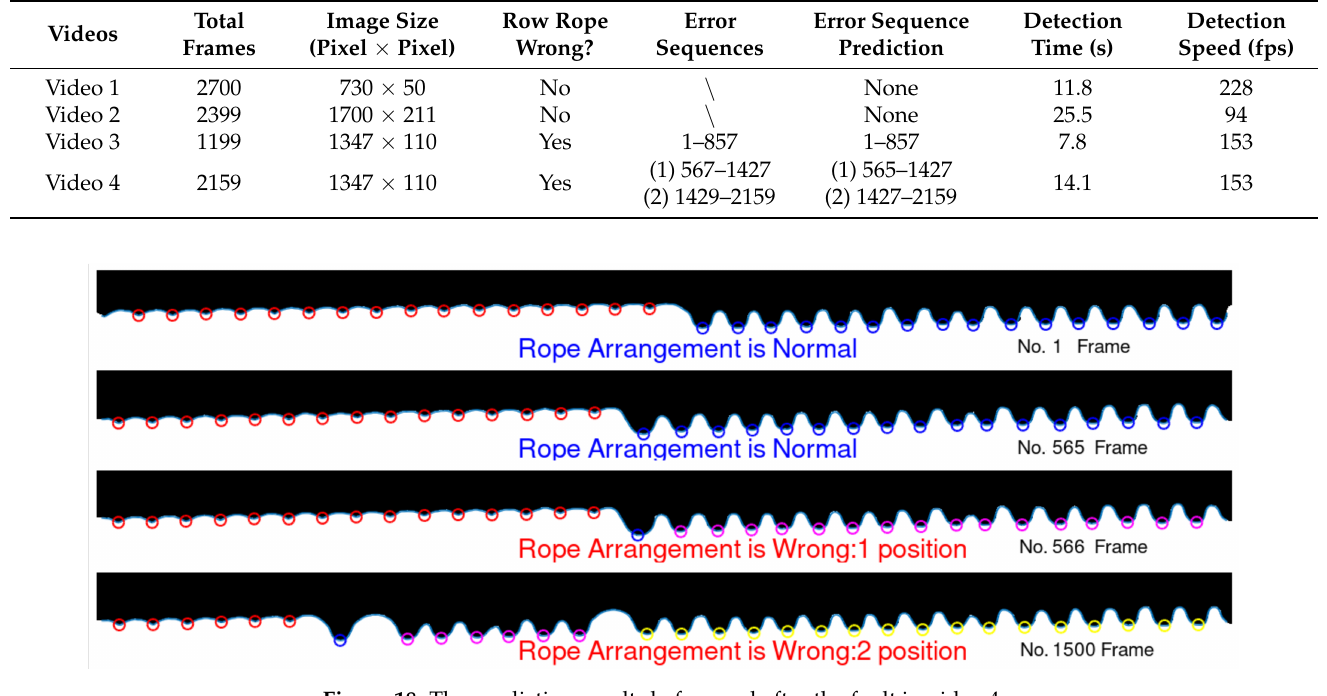
Figure 18. The prediction results before and after the fault in video 4.